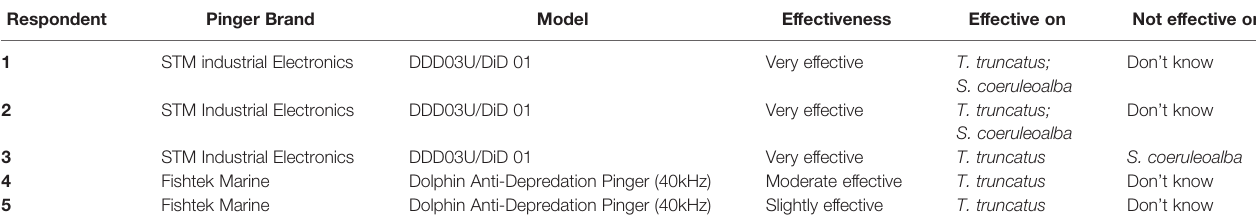
TABLE 2 | Depredation mitigation measure (dolphin anti-depredation pinger) used by longline fi shers and their effectiveness on mitigating dolphin interactions.